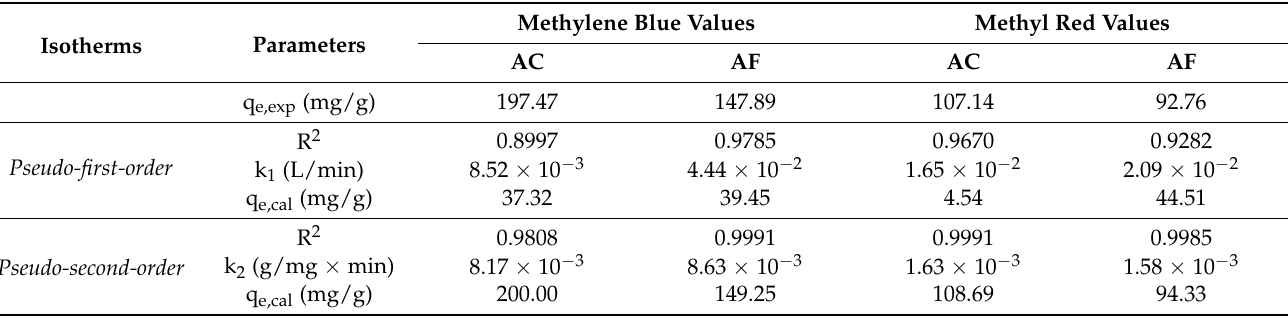
Table 6. Kinetic parameters of adsorption of organic